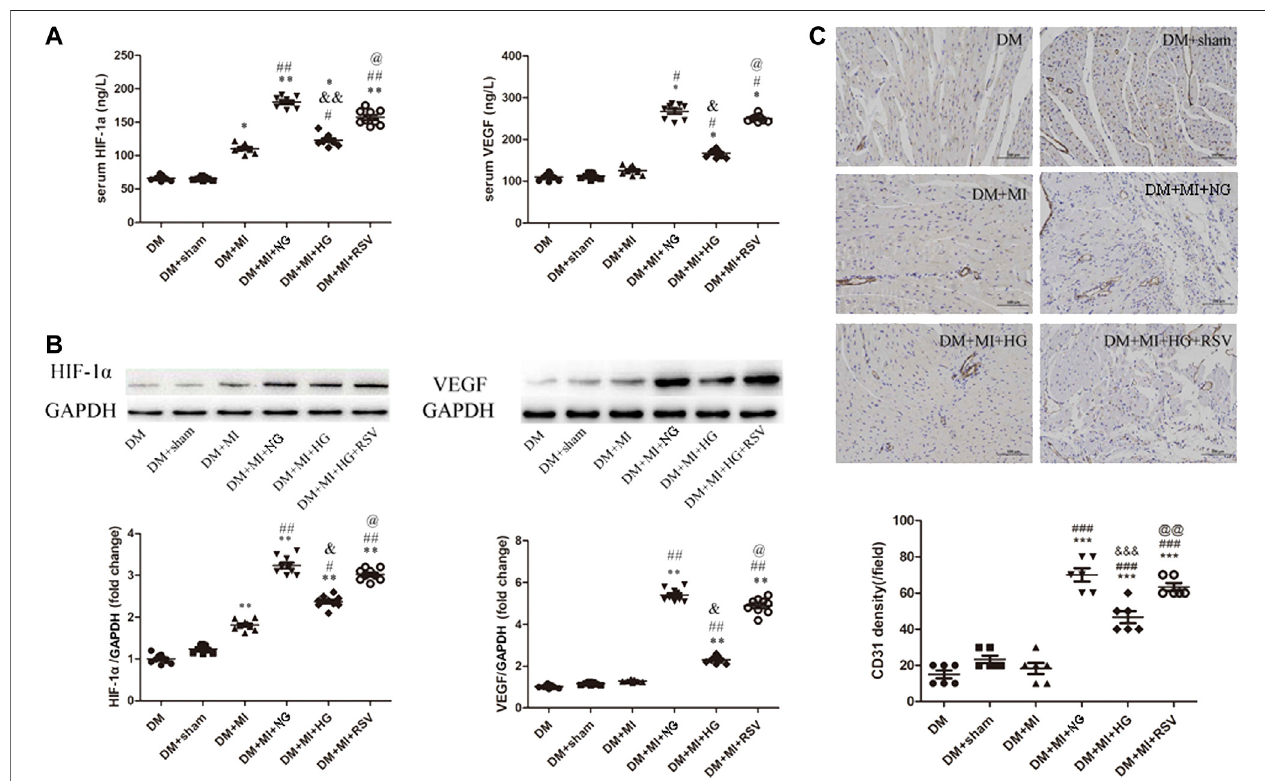
FIGURE 6 | RSV-MSCs enhance angiogenesis in the infarcted hearts of DM rats (A) ELISA was used to detect the pro-angiogenic factor of HIF-1 α and VEGF expression, (B) andWBwasusedtodetecttheproteinexpressionofHIF-1 α andVEGFintheheartsection. (C) RepresentativeimagesofCD31stainingandquantitative analysisofthedensityofarteriolesofhearttissuefromcontrolgroupandexperimentalgroup.Scalebar (cid:2) 100 μ m.Dataareexpressedasthemean ± SEM.* p ＜ 0.05vs DM sham. ## p ＜ 0.01 vs DM + MI. & p ＜ 0.001 vs DM + MI + NG. @ p ＜ 0.05 vs DM + MI +